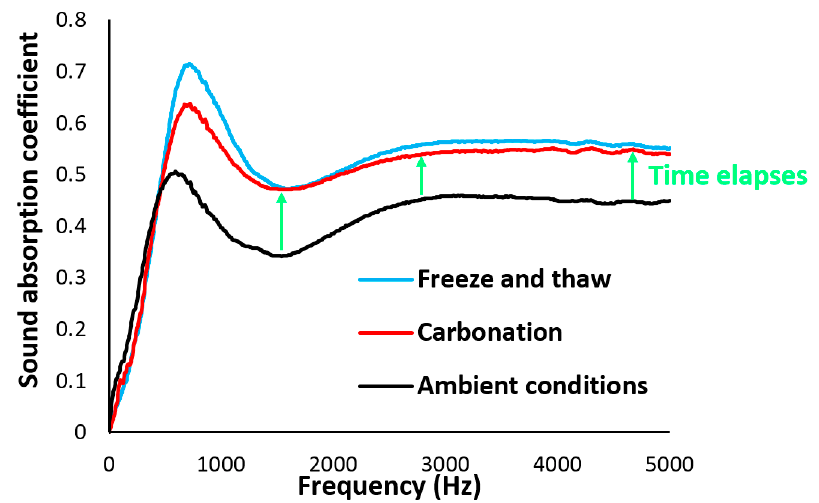
Figure 13. Sound absorption of acoustic panels under different conditions.